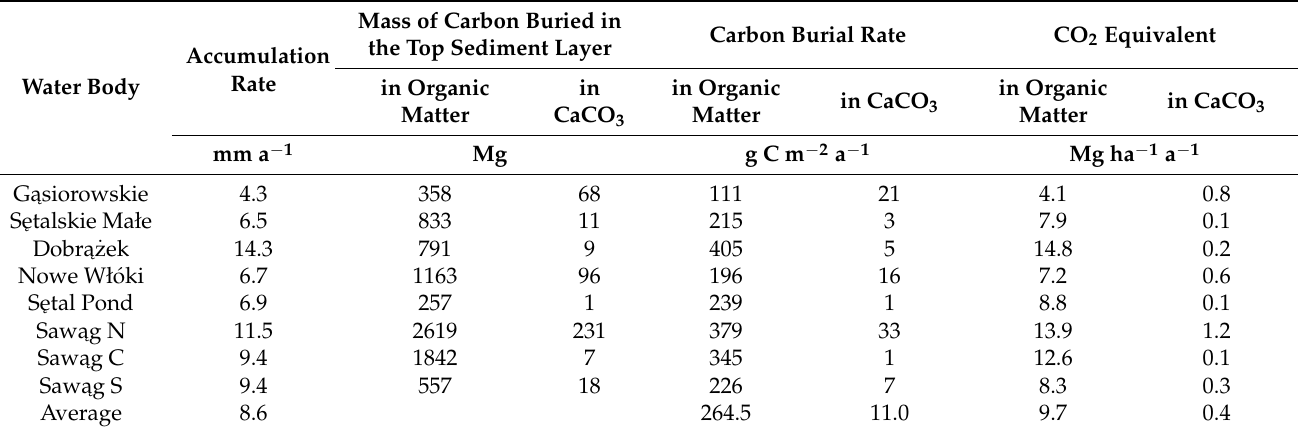
Table 5. Estimated total and average annual carbon accumulation capacity for the post-restoration period in the analysed water bodies based on available